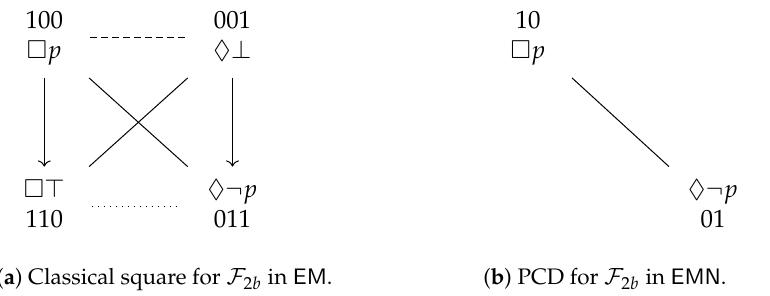
Figure 11. Aristotelian diagrams for F 2 b = { (cid:3) p , (cid:3) (cid:62) , ♦ ⊥ , ♦ ¬ p } in two non-normal modal